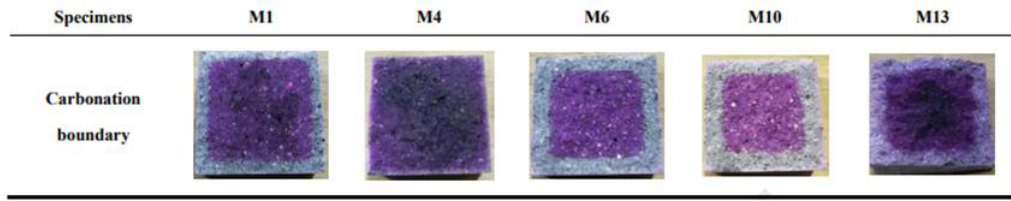
Figure 7. Schematic diagram of accelerated carbonation device [103].